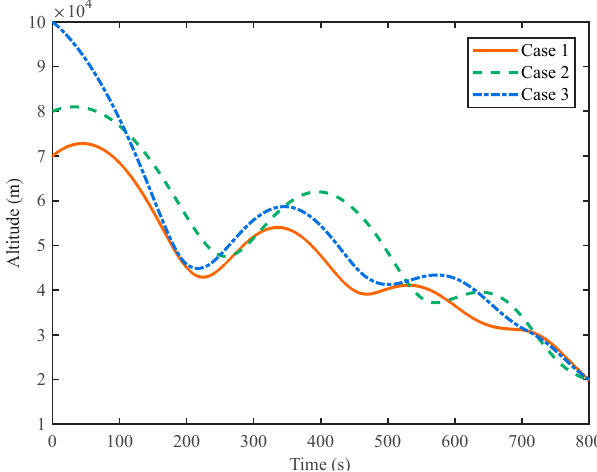
Figure 22. Time histories of the altitude.